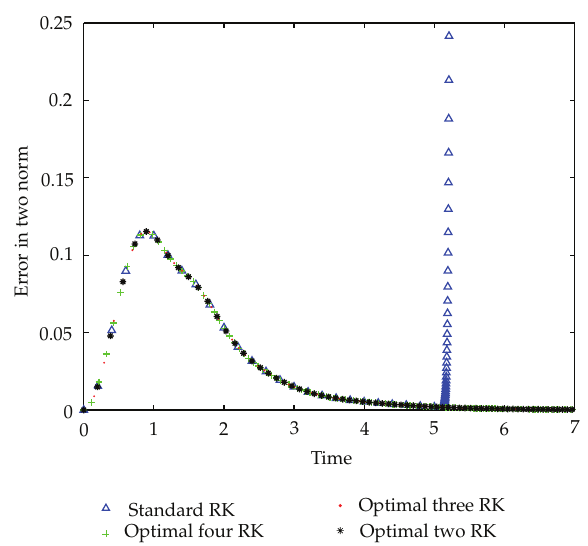
Figure 3: Relative error between numerical simulations and the analytic solution. Table 1: Comparison for number of iterations among optimal two-stage RK, RKF 23, and standard two- stage RK. The optimal two-stage RK method is counted twice for the function evaluation per iteration, while the RKF 23 is counted four times per iteration. “Div” is the abbreviation for Divergent. Method/Time 1 2